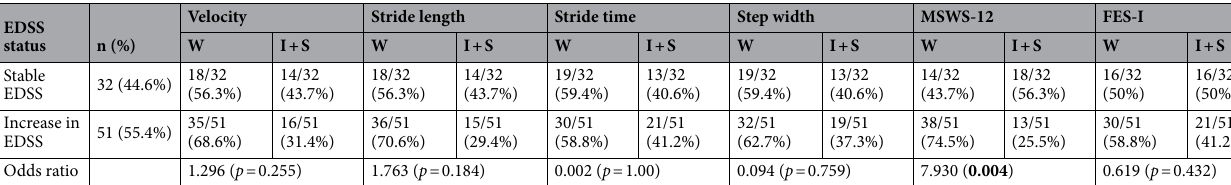
Table 3. Distribution according to EDSS status and mobility performance status in the total sample (n = 83). Classification is based on condition at M2 compared with M1. Worsening is considered as any decrease in walking speed, shorter stride length, increased stride time, wider based of support, more self-reported mobility difficulties (MSWS-12), and increased fear of falling (FES-I) at M2 compared with M1. W worsening, I improved, S similar. Significant values are in [bold].